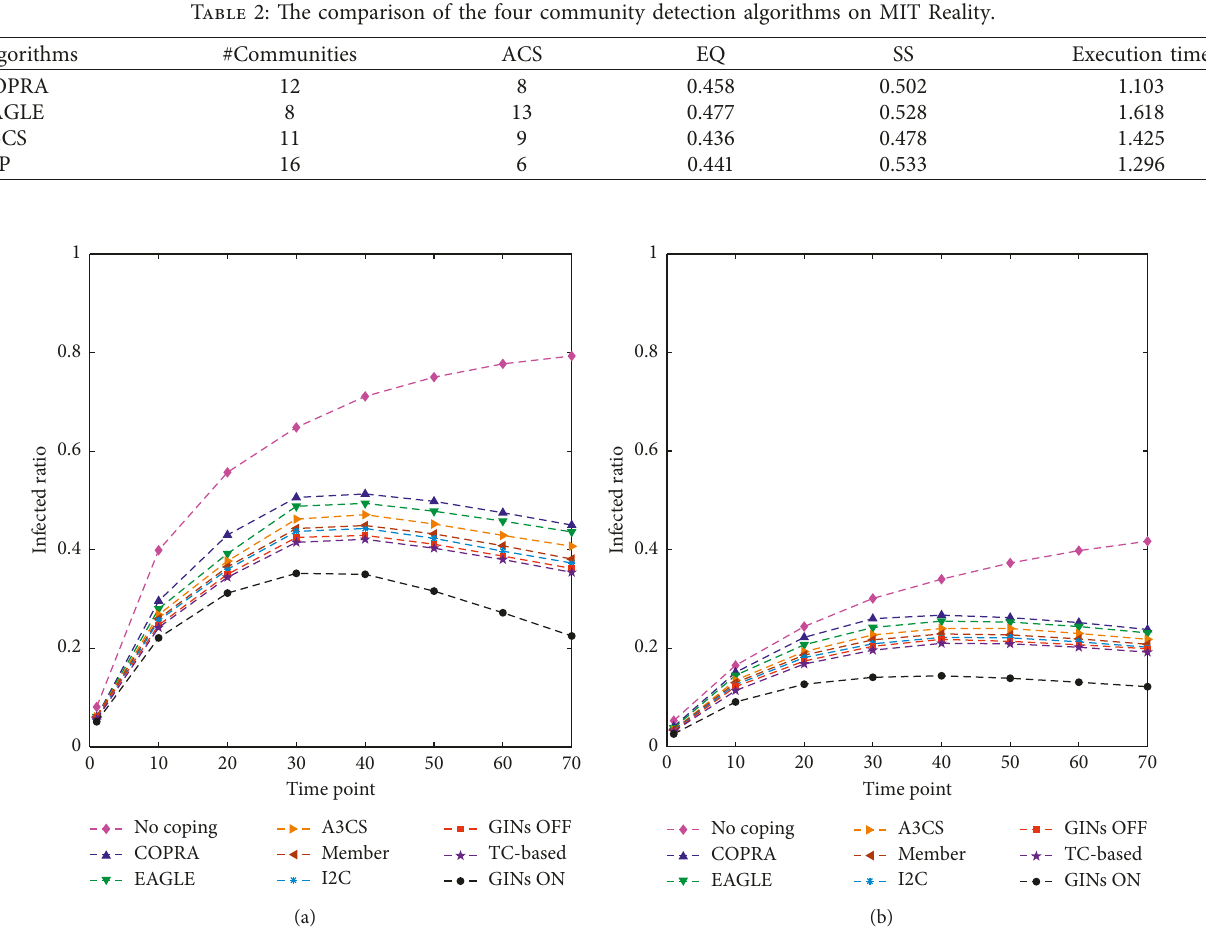
Figure 7: Performance comparison of long-range coping schemes on Haggle (a) and MIT Reality